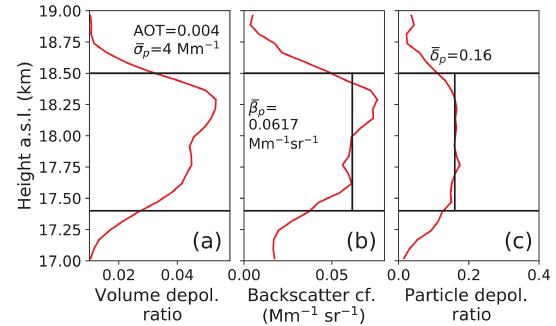
Figure 2. Analysis of a Polly measurement at Limassol, Cyprus, on 9 September 2017. The 532nm backscatter and depolarization ratio profiles are computed from 6h mean lidar return signal pro- files (18:00–24:00UTC). Vertical signal smoothing with a window length of 367.5m is applied. The volume depolarization ratio in (a) and the particle backscatter coefficient in (b) were used to identify the smoke layer. The shown smoke layer base and top heights (hor- izontal lines) are mean values for the observation period, estimated from subsequent 60–90min mean depolarization ratio profiles. The particle depolarization ratio in (c) is the one for smoke (after the correction for Rayleigh depolarization contributions). Values for the vertically averaged particle extinction coefficient σ p (for the column from z bot and z top , assuming a lidar ratio of 65sr) and 532nm AOT, mean backscatter coefficient β p , and mean particle linear depolar- ization ratio δ p are stated in the three